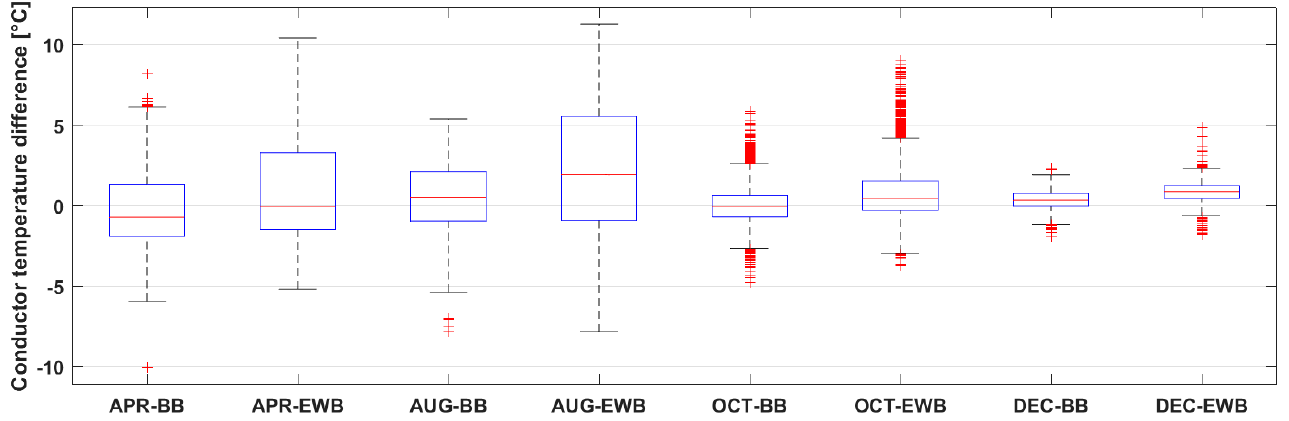
Figure 6. Boxplot diagrams of the black-box and extended white-box models for four different months.